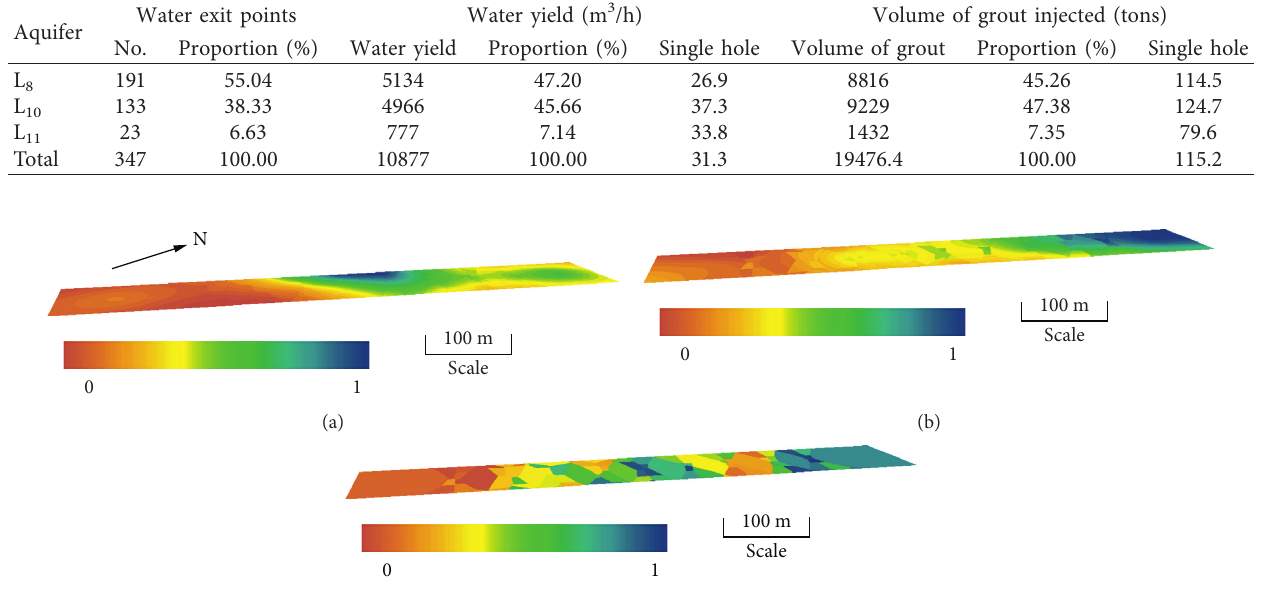
Table 2: Proportion of water yield and volume of grout injected.